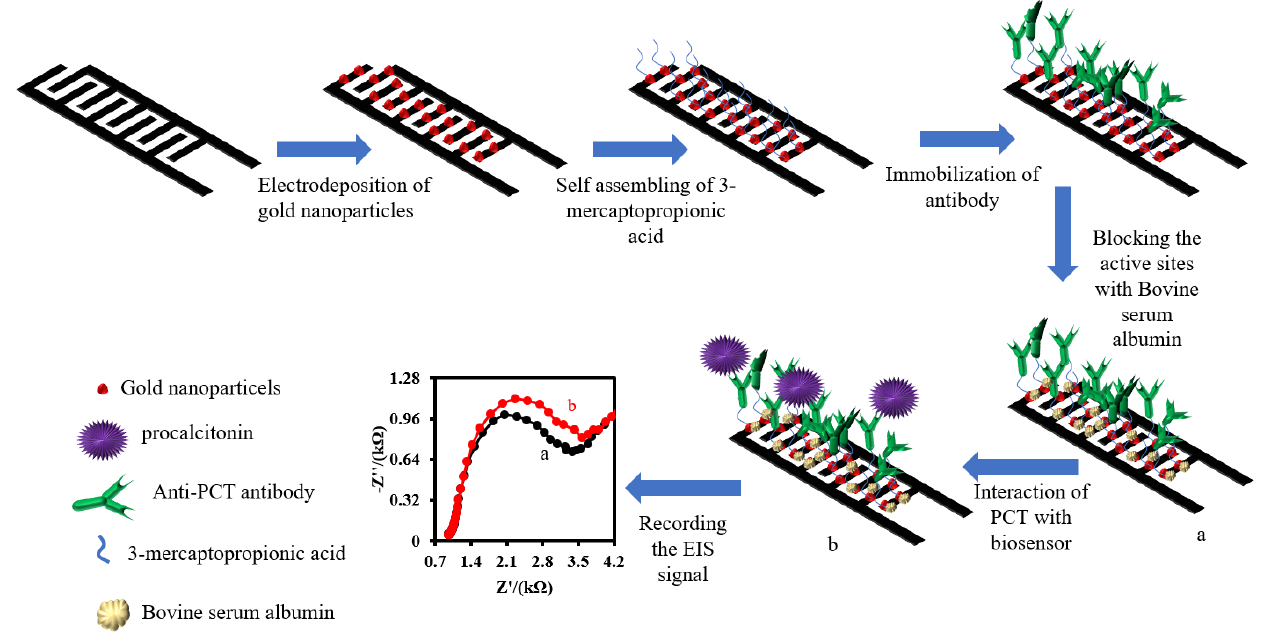
Figure 1. Schematic illustration of the fabrication of IDGE/Au nano /3-MPA/Anti-PTC/BSA and response mechanism for PTC antigen.